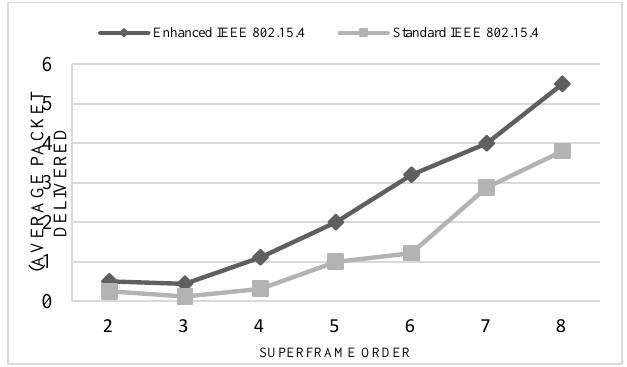
Fig. 6. Comparison between average packet delivered resulted from original and enhanced standard